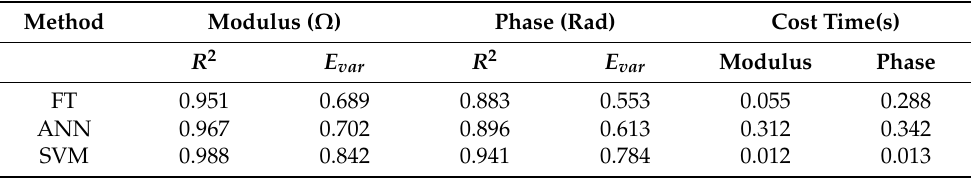
Table 2. The accuracy comparison of models based on different